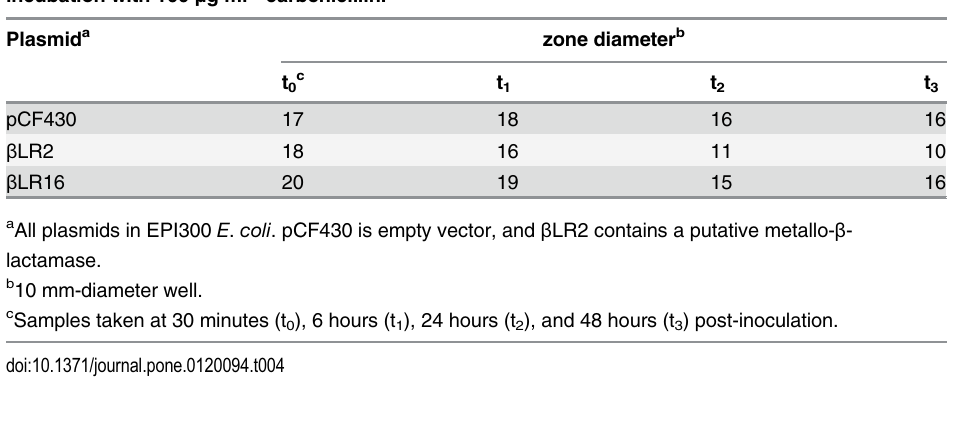
assigned to the OmpR/PhoB family of response regulators [26]. The function of either of the proteins described above in their host organism is not known.